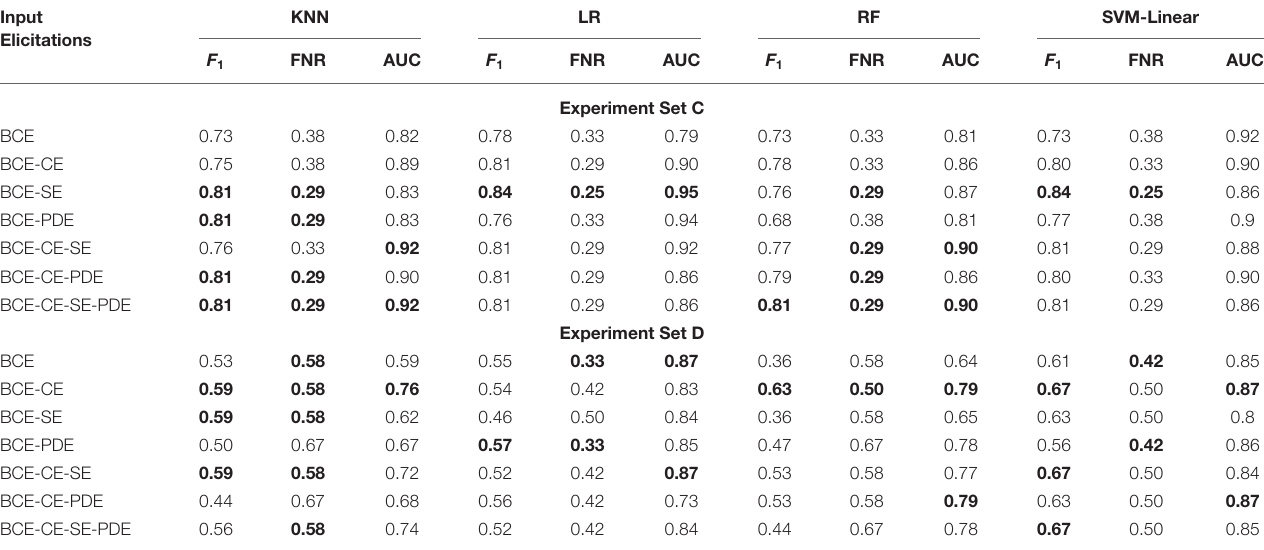
TABLE 5 | Performance analysis of crowdsourcing based ML methods for imbalanced datasets. Input